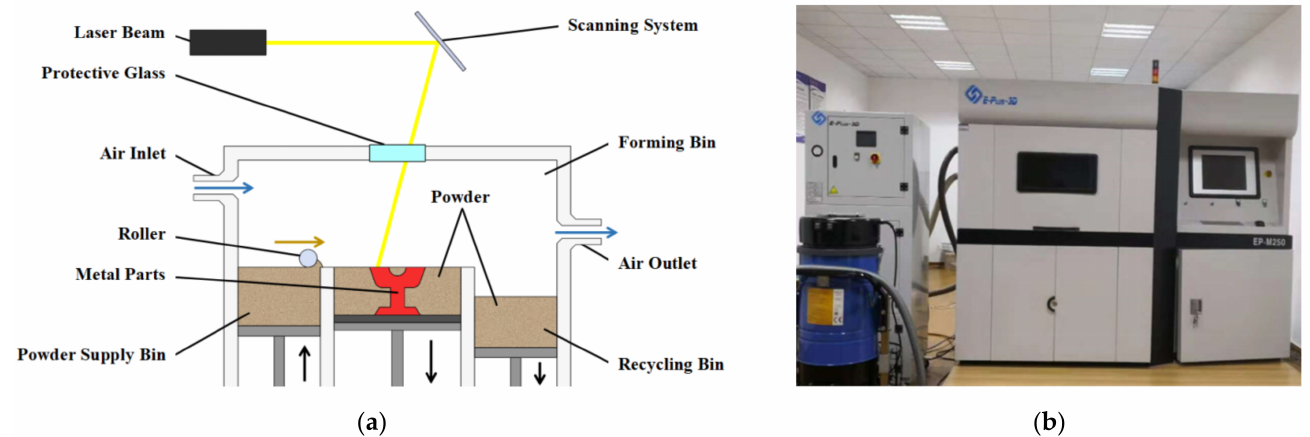
Figure 2. ( a ) Schematic of laser powder bed fusion forming. ( b ) EP-M250